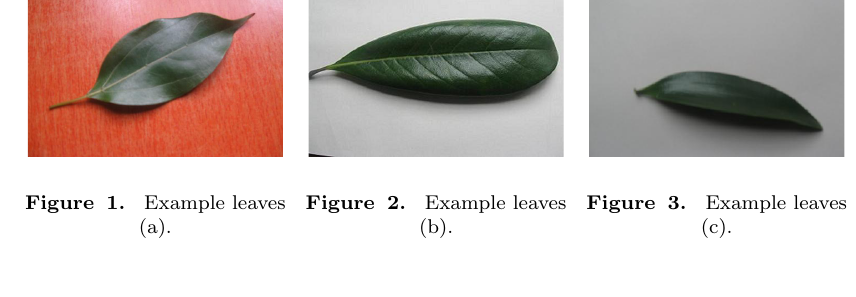
Figure 1. Example leaves (a).